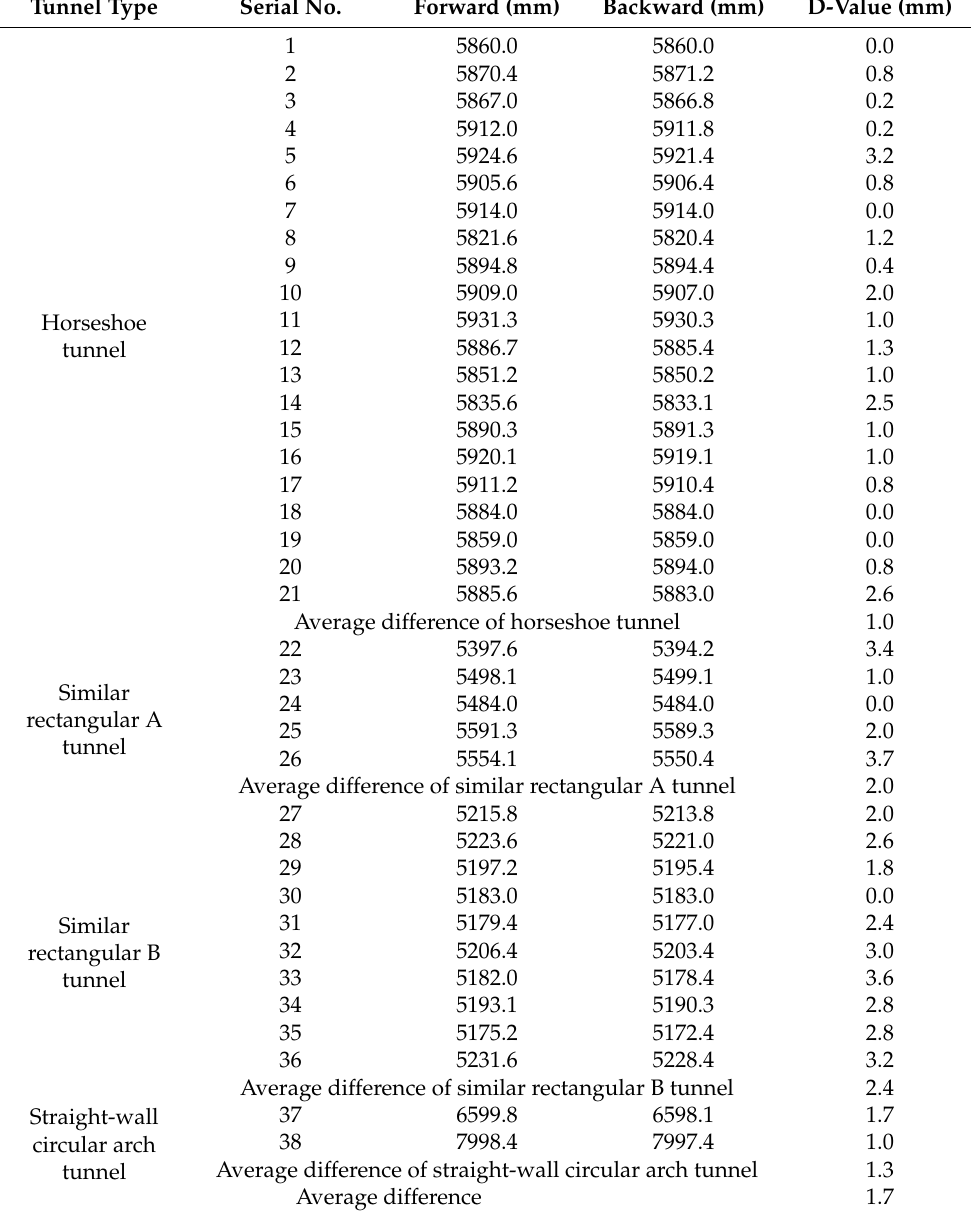
Table 3. Comparison of chord length accuracy of roundtrip measurement.